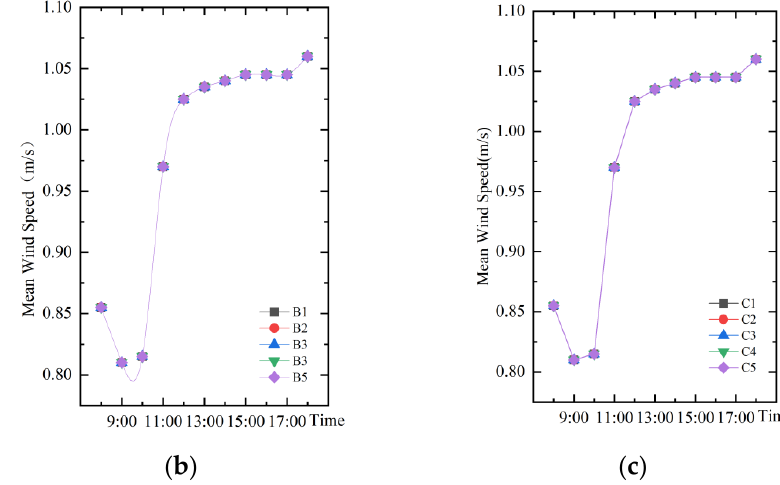
Figure 10. The trend of temporal mean wind speed change for different water body layout factors: ( a ) Water body area index; ( b ) Water body dispersion index; ( c ) Water body shape